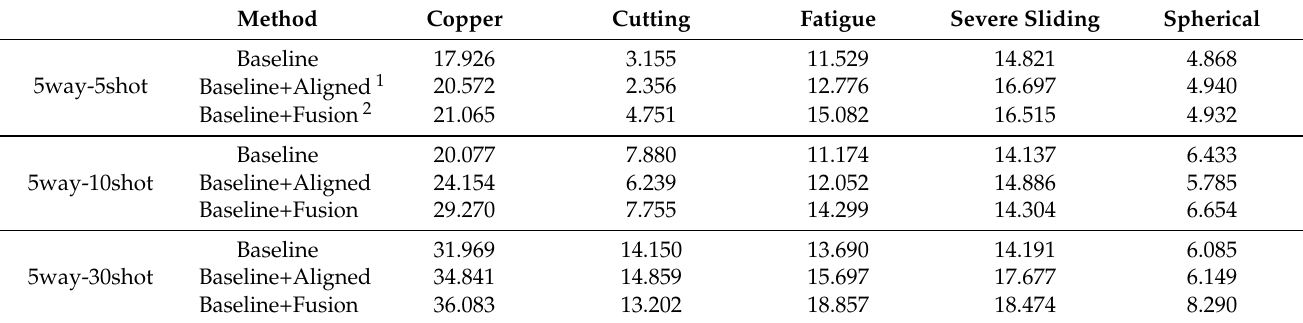
Table 4. AP accuracy for each category.